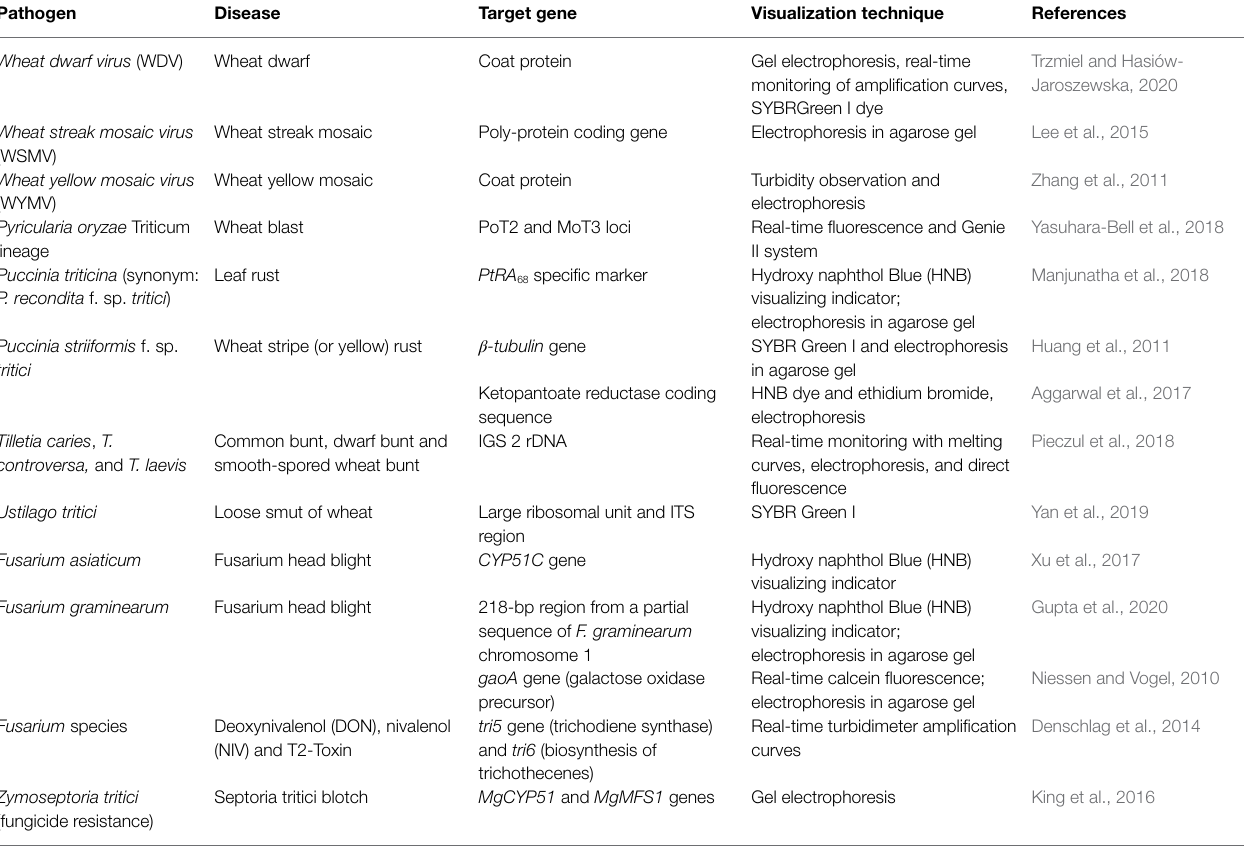
TABLE 1 | LAMP-based detection of various pathogens in wheat. Pathogen